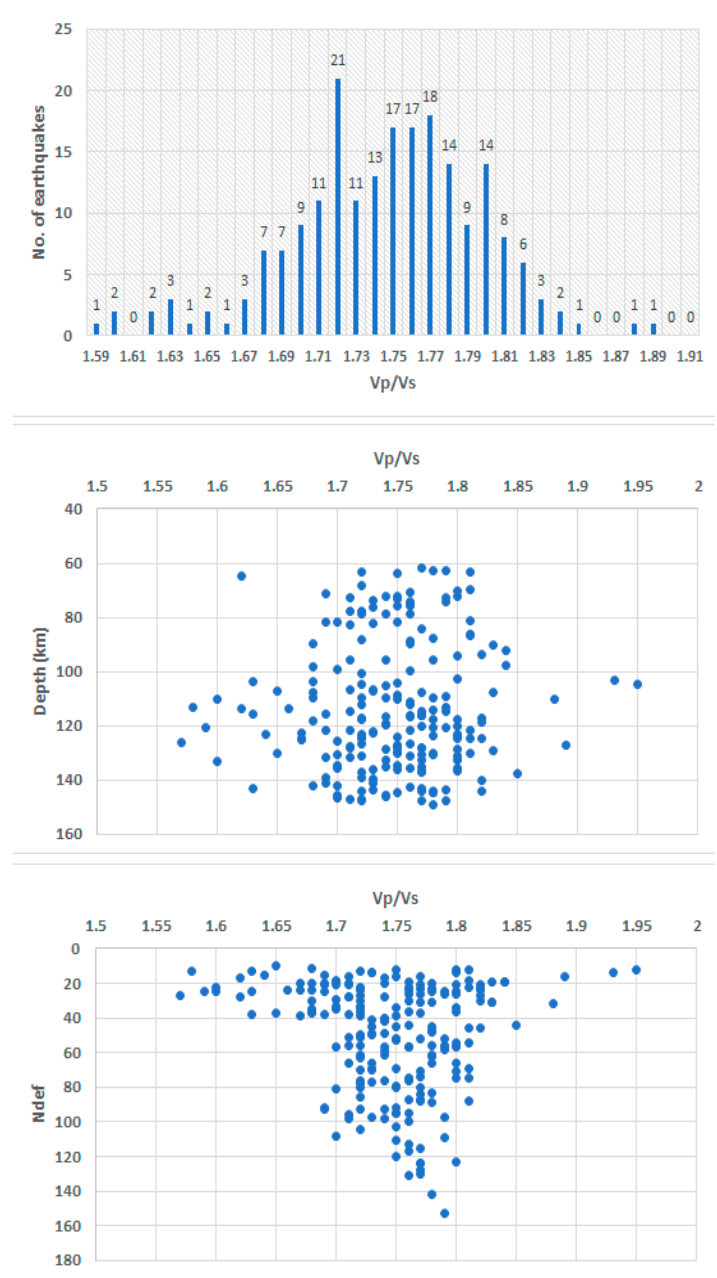
Figure 5. Distribution of Vp/Vs ratios as a function of: number of events ( top ), earthquake depth ( middle ), and number of seismic phases used in the location process ( bottom ).